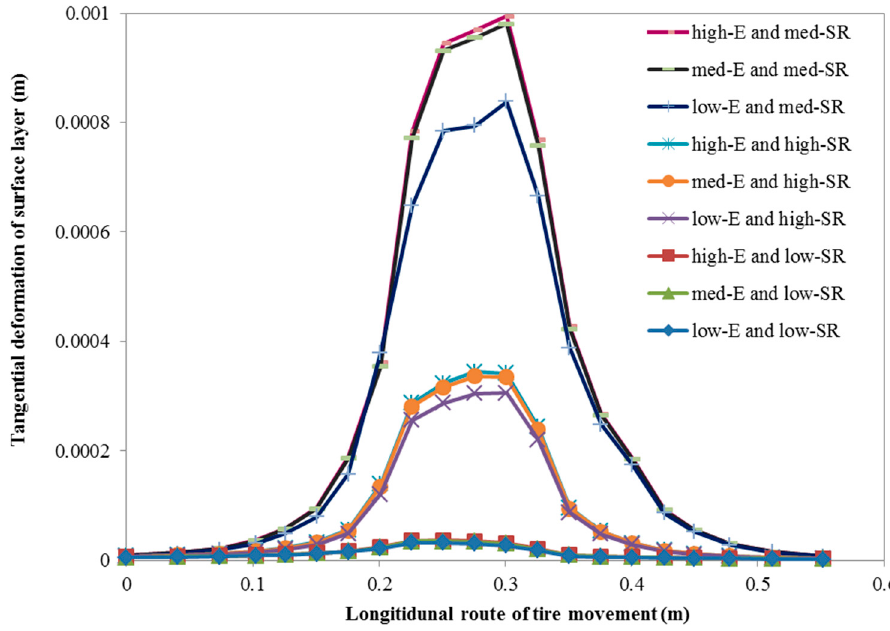
Figure 8. Tangential deformation of pavement surface layer under different slip ratios of tires.